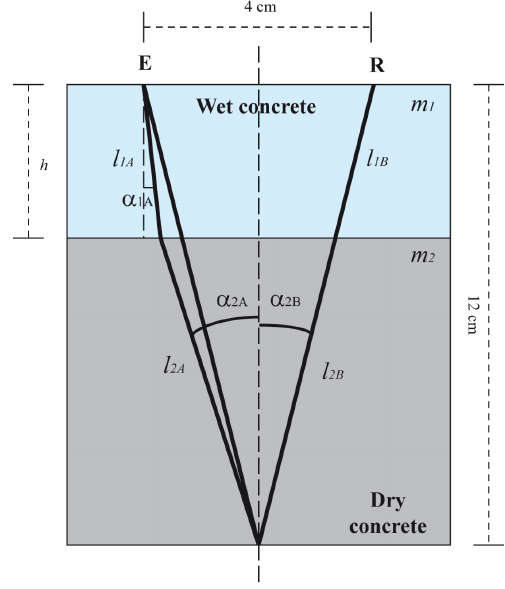
Figure A1. Electromagnetic traveling paths